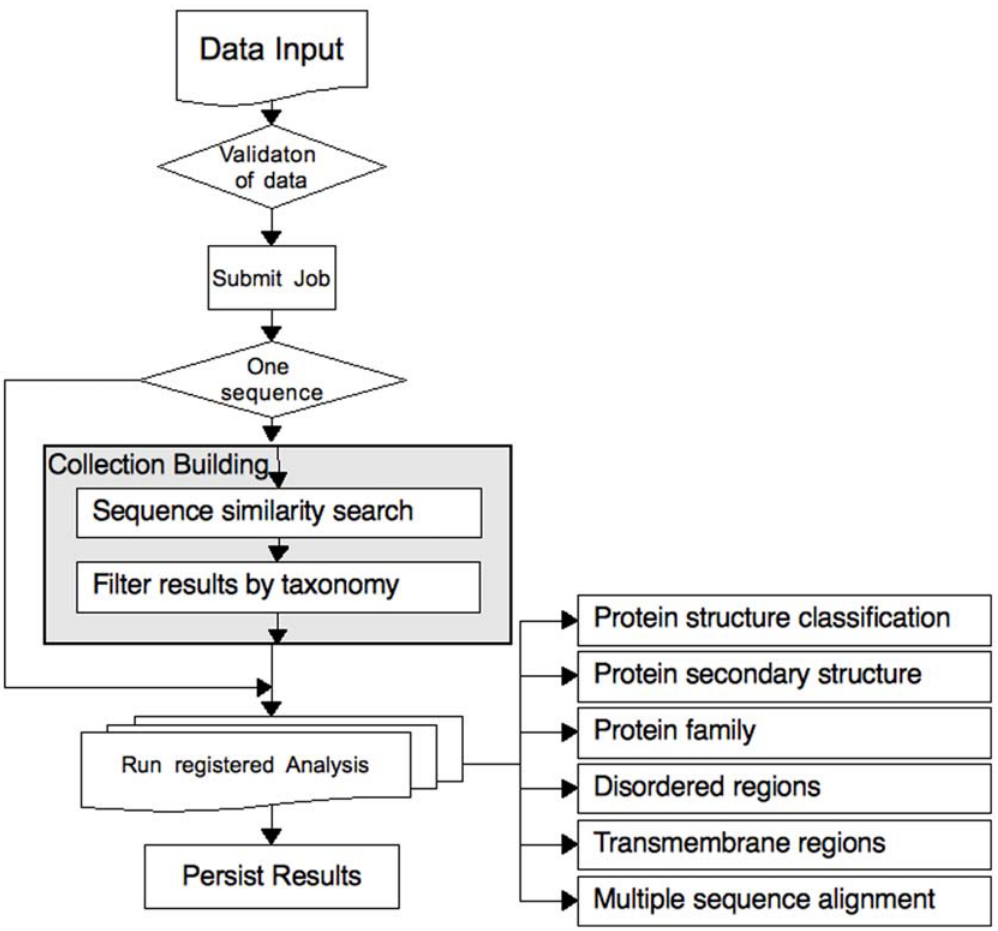
Figure 3. overview of the analysis flow in ProteinArchitect.